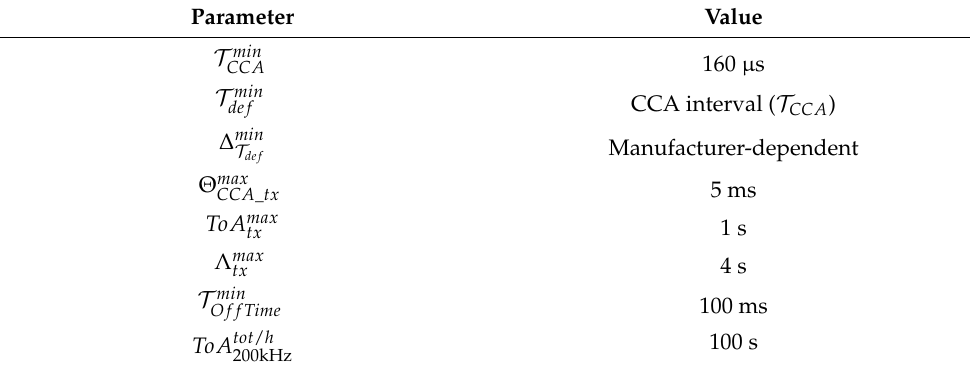
Table 4. Timing parameters of polite medium access based on LBT